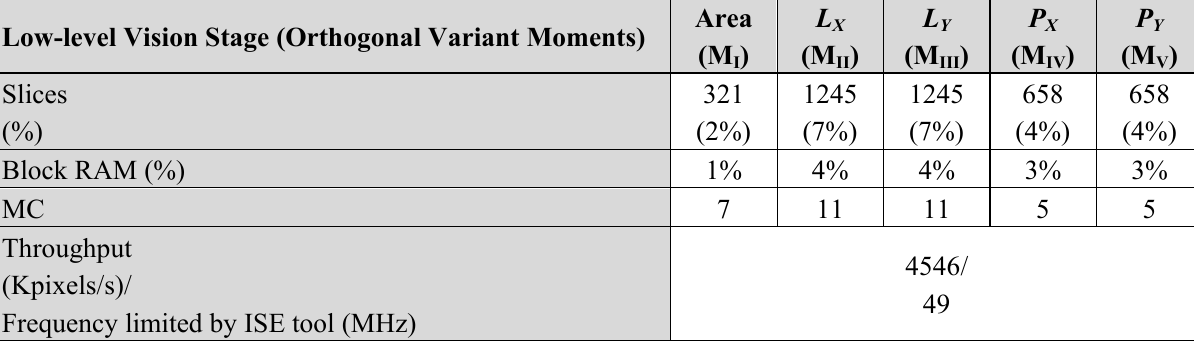
Table 2. Slices, memory requirements, number of cycles and performance for the implementation of Low-level vision. Orthogonal moment